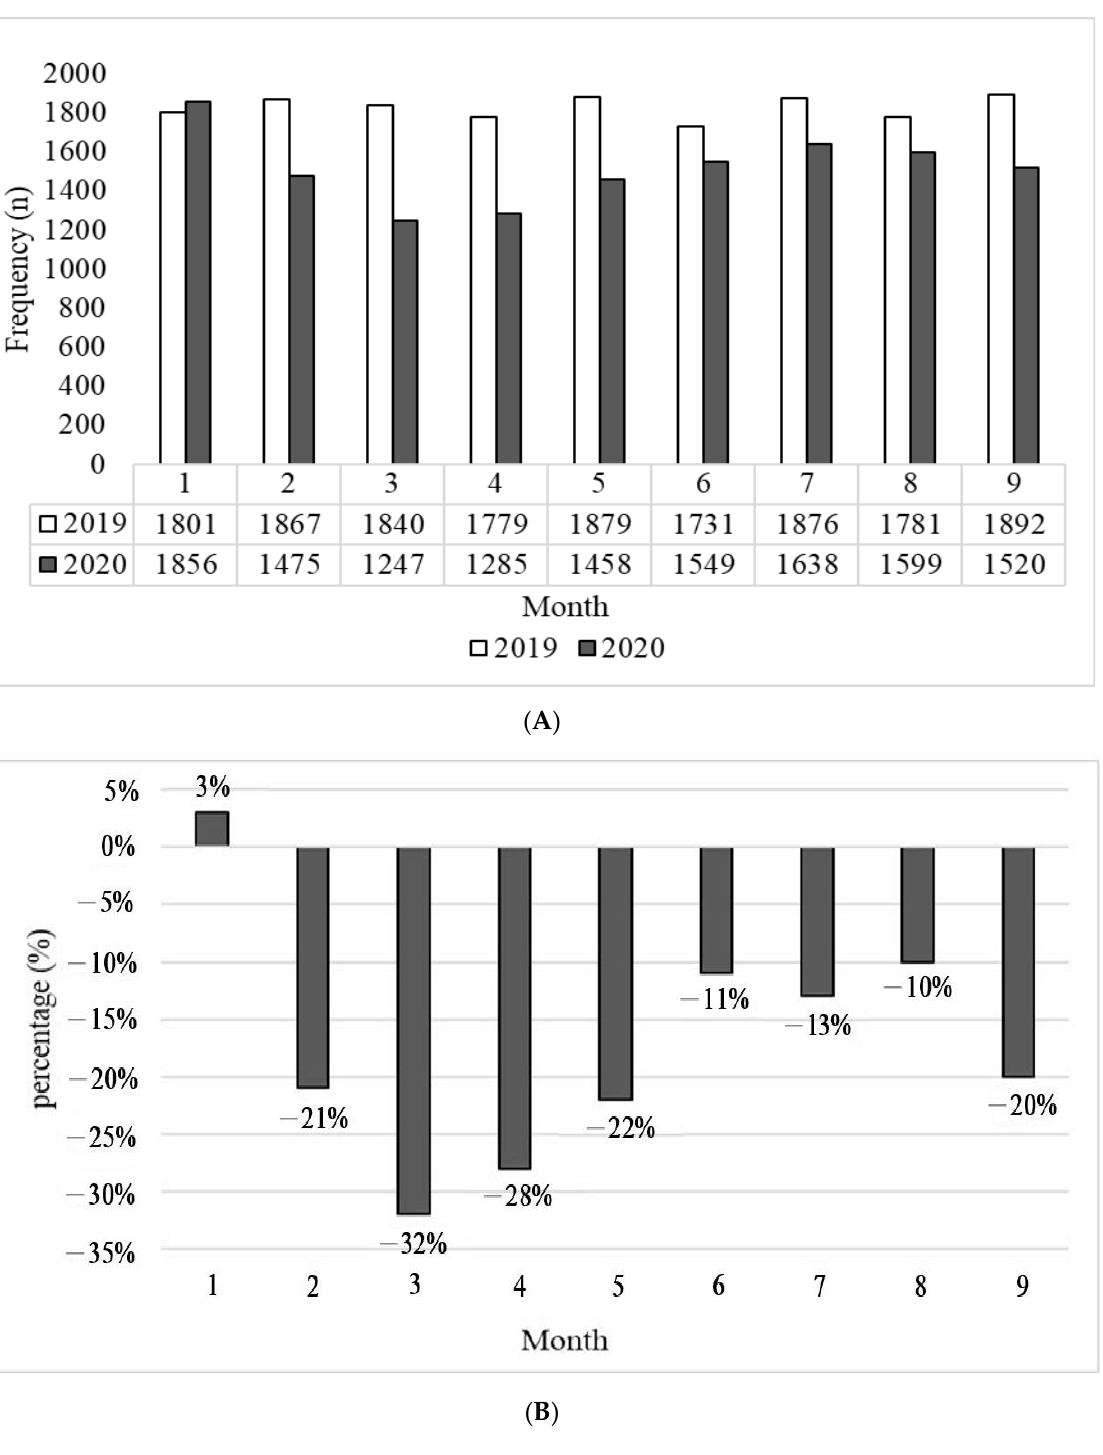
Figure 1. ( A ) Total number of emergency department (ED) visits between the COVID-19 pandemic and the pre-pandemic period. ( B ) Comparison of percentage changes in emergency department (ED) visits between the COVID-19 pandemic and the pre-pandemic period. Regarding treatment outcome, there was a decrease in the overall of average ED LOS during the COVID-19 pandemic period, with 6.7 ± 10.9 h for non-hospitalization patients, 18.0 ± 16.6 for hospitalization patients, 18.4 ± 16.6 for patients transferred to the general ward, and 14.0 ± 16.5 for patients transferred to ICU. Non-hospitalization, hospitalization, and transfer to the general ward were significantly lower than in the pre-pandemic period in LOS ( p < 0.001).